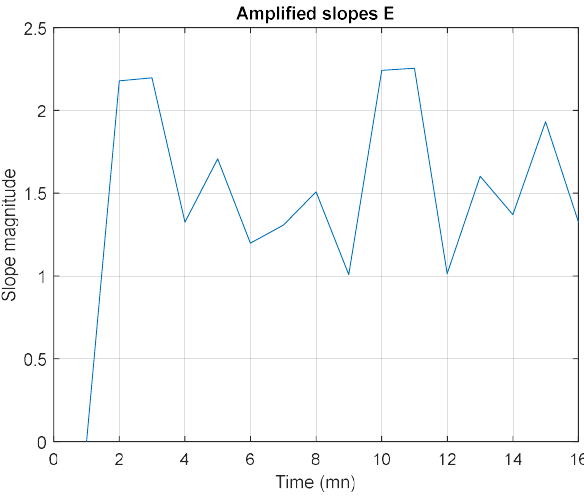
Figure 4. Amplification of S.